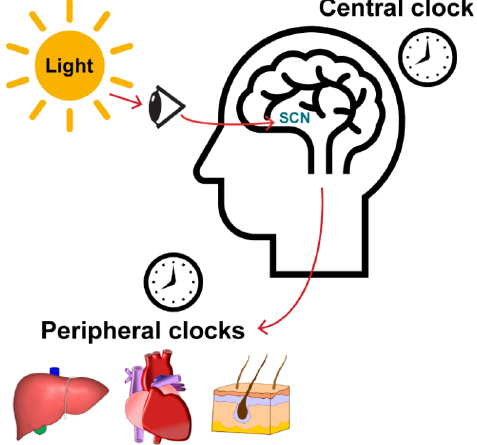
Figure 2. Central and peripheral circadian clocks. The body’s central or “master” clock is found in the suprachiasmatic nucleus (SCN) in the brain, which receives input from photosensitive, mel- anopsin-containing retinal ganglion cells via the retinohypothalamic tract. Through neuronal and hormonal signaling, the SCN then sends signals to peripheral organs to synchronize these periph- eral clocks with the master clock in the